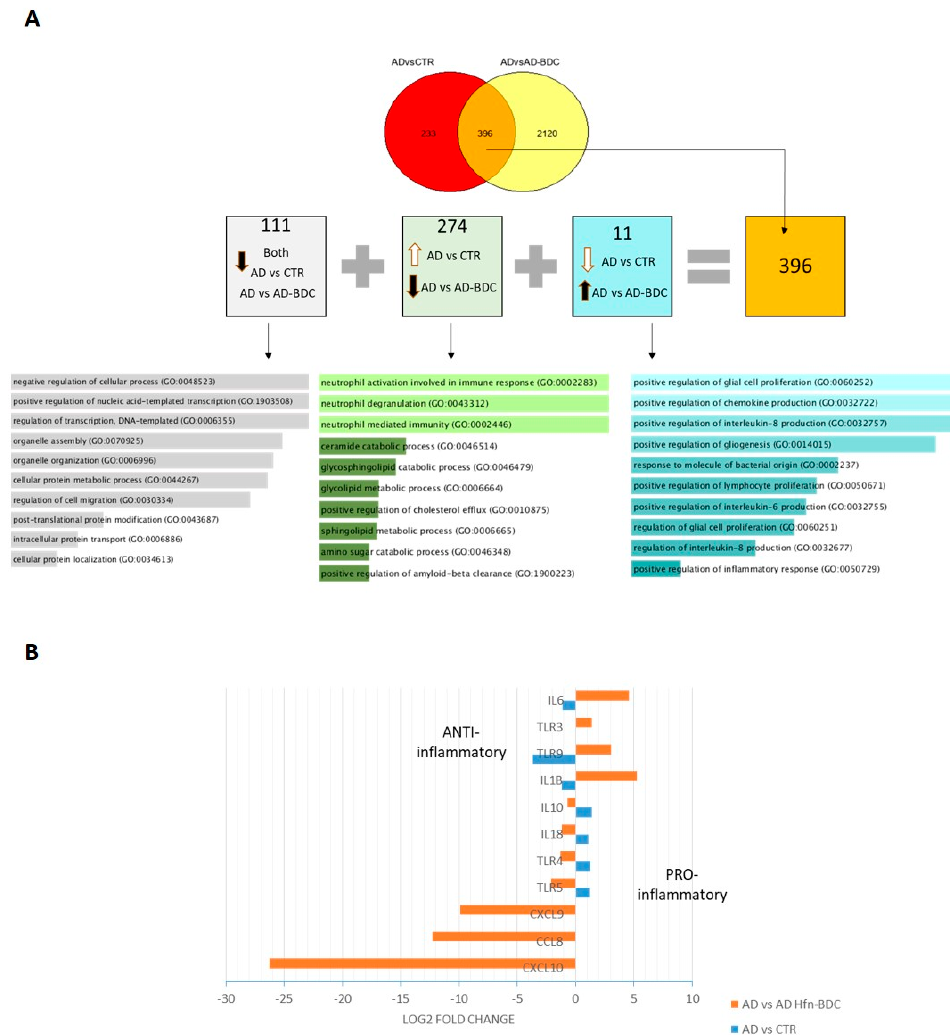
Figure 6. Comparison between DEG genes obtained by AD_NT vs. CTR_NT and AD_NT vs. AD_Hfn_BDC. ( A ) Venn diagram of DEG genes in AD before and after treatment, and its distribution in terms of the deregulation sign of 396 common genes found. Lists of genes are reported in Table S6. For each group, GO biological process analysis have been reported. ( B ) Graphical representation of the main genes that change with AD BDC-HFn